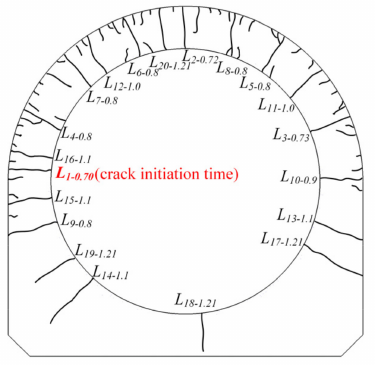
Figure 9. Crack distribution and propagation of the SLRCP.